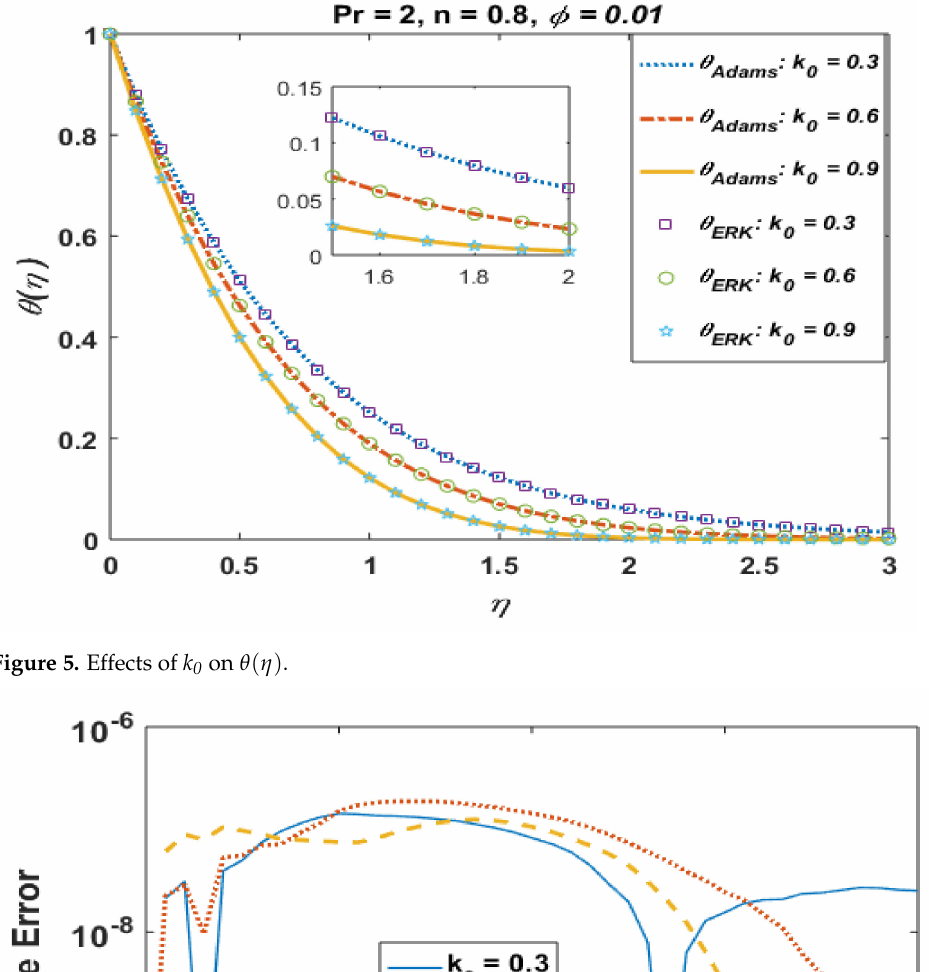
Figure 5. Effects of k 0 on θ ( η ) .